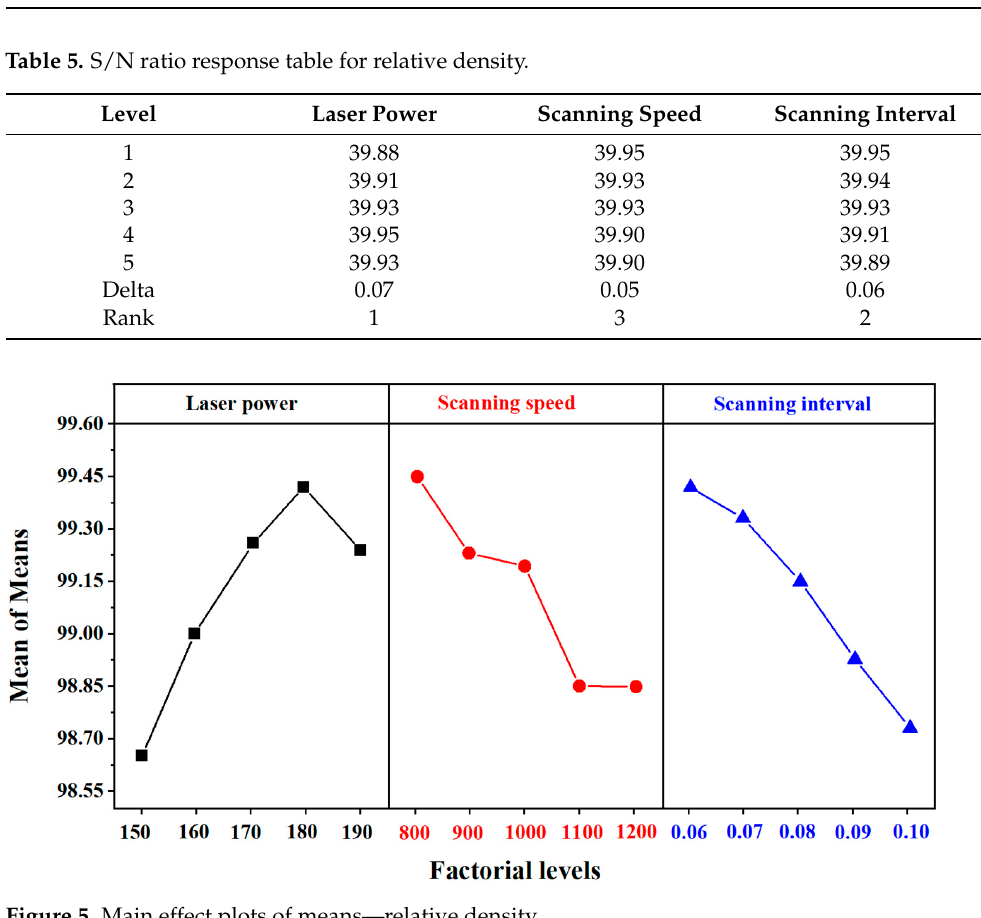
Figure 5. Main effect plots of means—relative density.